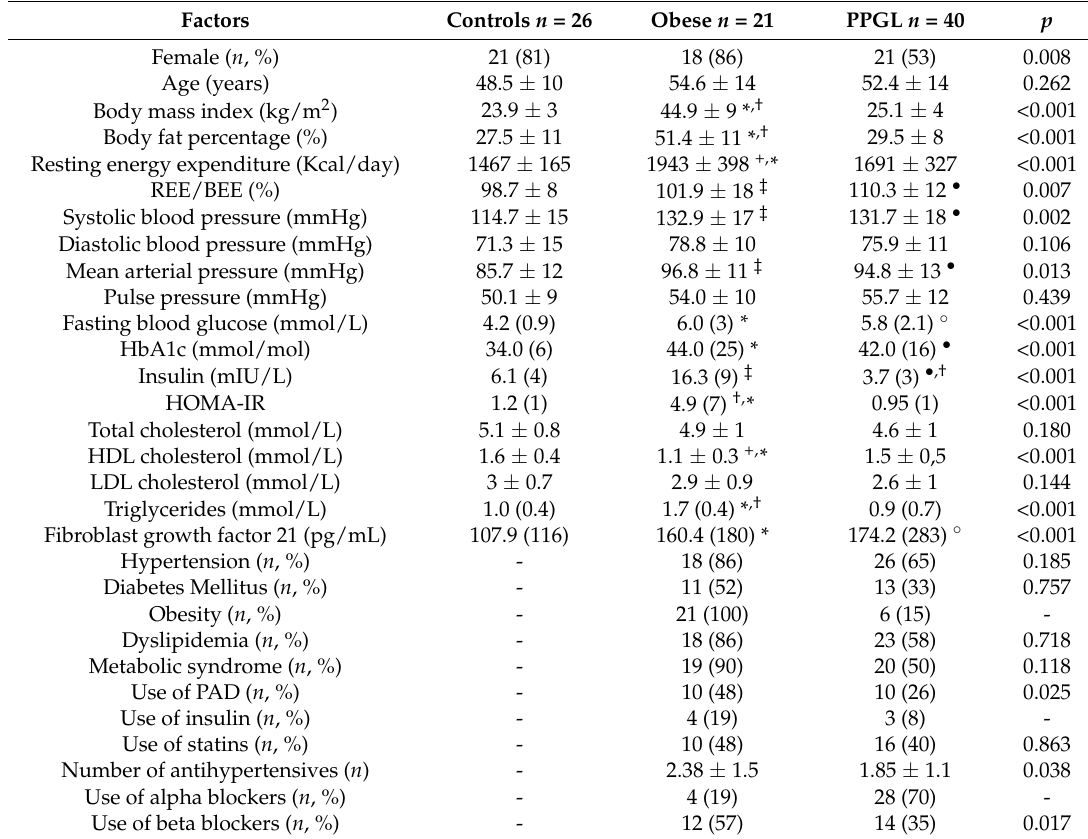
Table 1. Clinical and metabolic characteristics of study subjects.